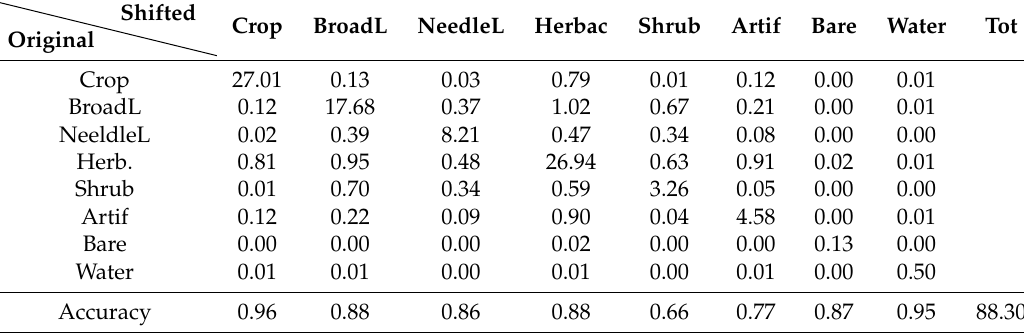
Table 4. Example of confusion matrix for a 1.5 pixel shift along the vertical Y